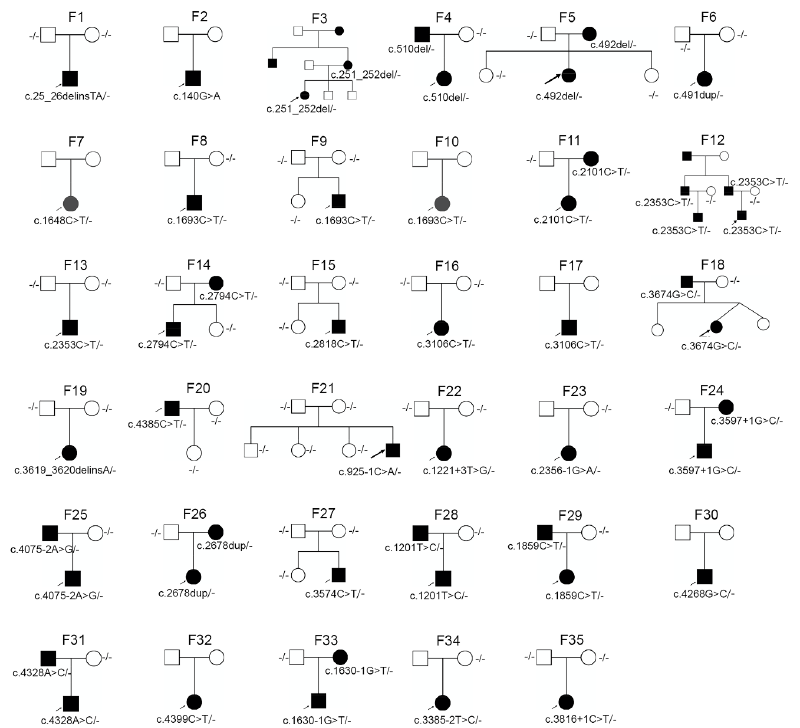
Figure 2. Pedigrees of families with COL2A1 and COL11A1 mutations. F1 to F27 are families with COL2A1 mutations, and F28 to F35 are families with COL11A1 mutations. The arrows indicate probands; the squares indicate men; the circles indicate women; filled symbols indicate affected individuals; open symbols indicate unaffected individuals.